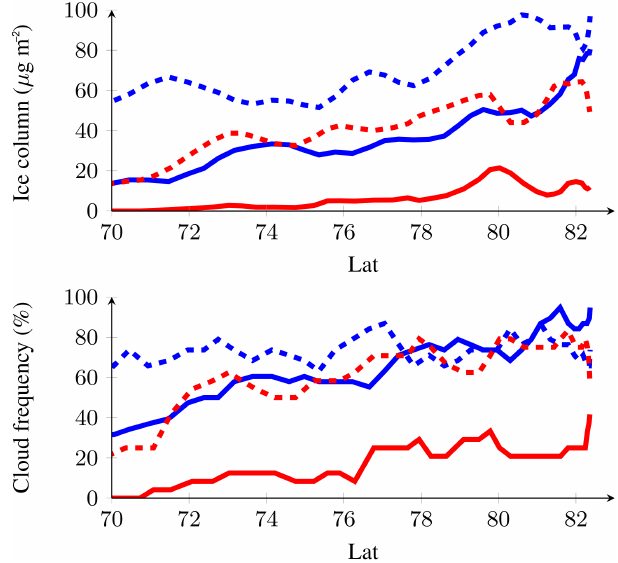
Figure 3. The latitudinal distribution of the ice column and the cloud frequency from the equilibrium model (dashed) and OSIRIS (solid) for measurements performed in July (blue) and August